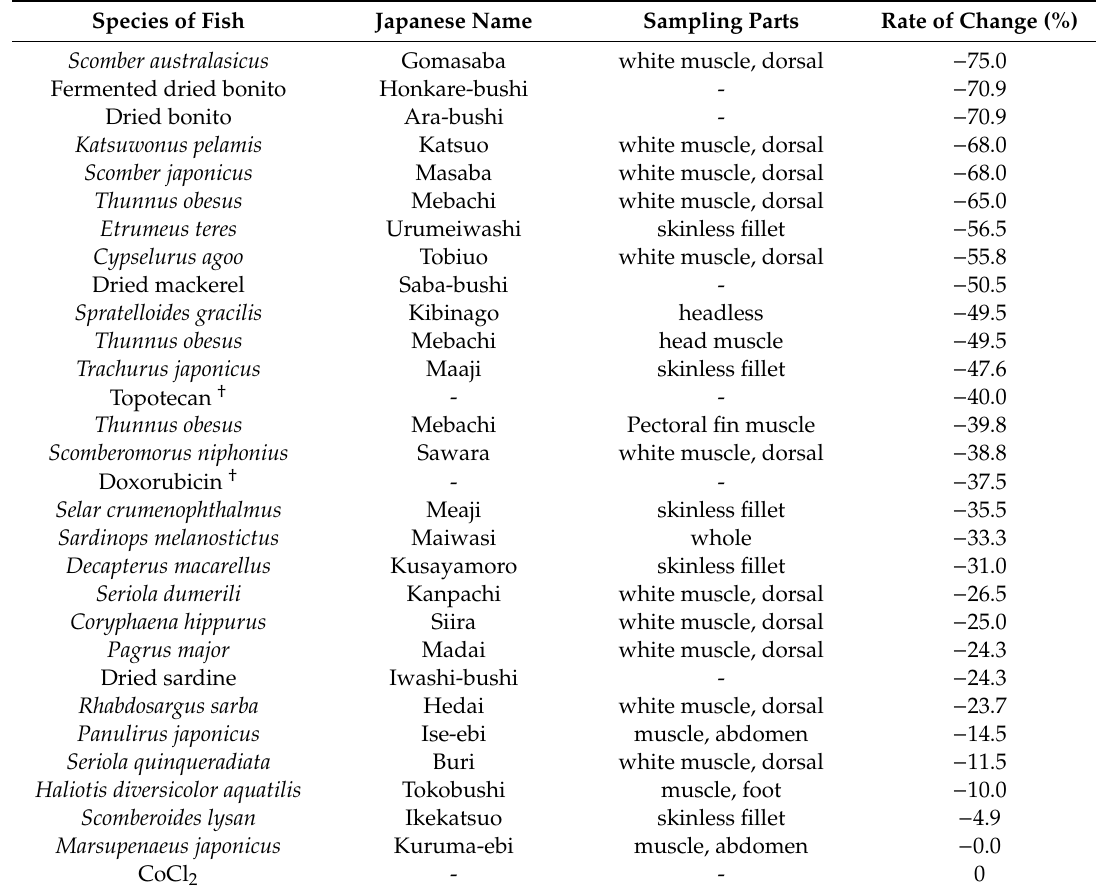
Table A1. The list of fishes showing HIF inhibitory e ff ects in the first screening and the rate of change of HIF activity compared with CoCl 2 -administrated controls ( † Positive control